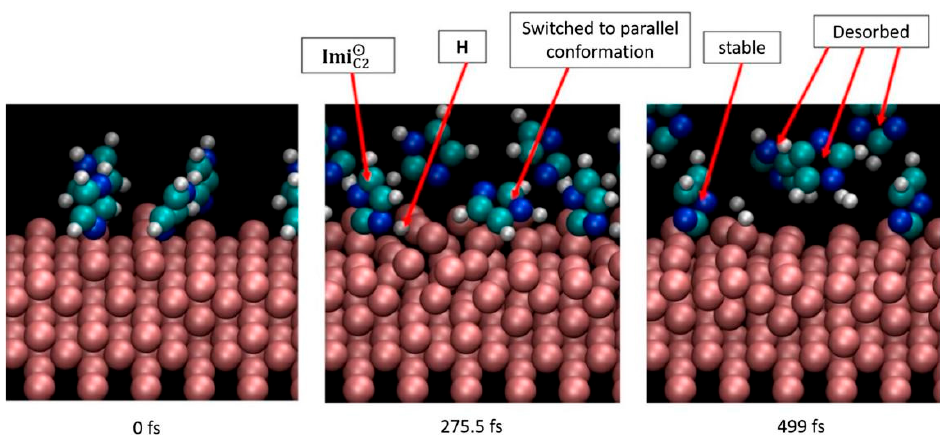
Figure 6. Imidazole molecules on an Fe(1 0 0) slab at 1500 K [71]. Chaitra et al. [76] combined electrochemical experiments and theoretical calculations to explain the anti-corrosion mechanism of triazole derivatives (BFBT, TMBT, and FNBT). The corrosion inhibition efficiency for mild steel in 0.5 M HCl could be explained in terms of the number of adsorption sites, molecular size and the way they interact with the metal surface. The inhibitors contained three nitrogen atoms, an amide bond and π electrons as adsorption centers. Therefore, the inhibitor was chemisorbed to the metal surface via these electrons through coordination bonds. The nitrogen atoms were easily protonated and physically bonded to positively charged mild steel surfaces via negatively charged chlo- ride ions (Cl − ). Bromine atoms had isolated pairs of electrons that were capable of trans- mitting them to the d orbital of the Fe and provided the highest inhibition efficiency of BFBT [77]. The FNBT exhibited the lowest inhibition efficiency due to the presence of the strongest passivating groups such as nitro, which reduced the electron density [78]. This